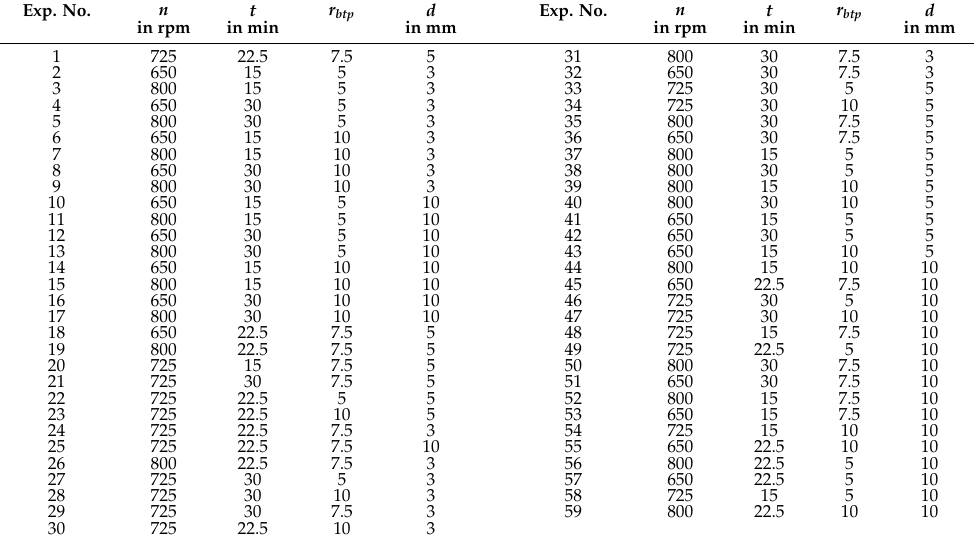
Table A1. Experimental plan for the high energy ball milling of Ni–Al powders in a 1:1 molar ratio with a systematic variation of milling